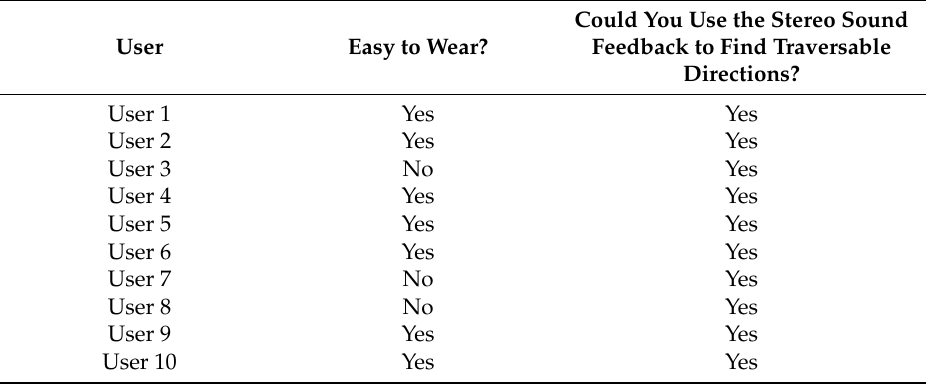
Table 3. Questionaire. After the field test, ten participants were asked two simple questions. Could You Use the Stereo Sound User Easy to Wear? Feedback to Find